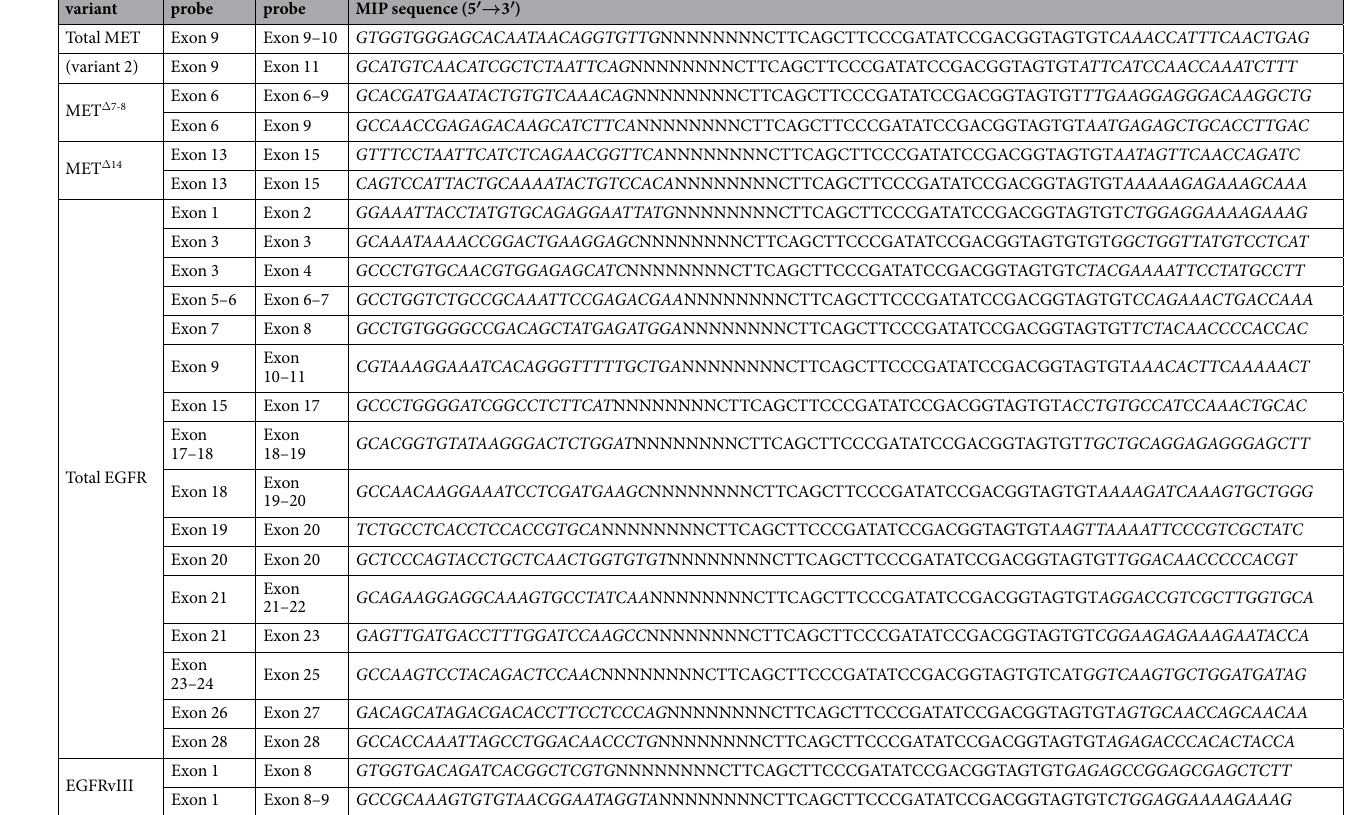
Table 1. SmMIP nucleotide sequences. Ligation and extension probes are depicted in Italic.